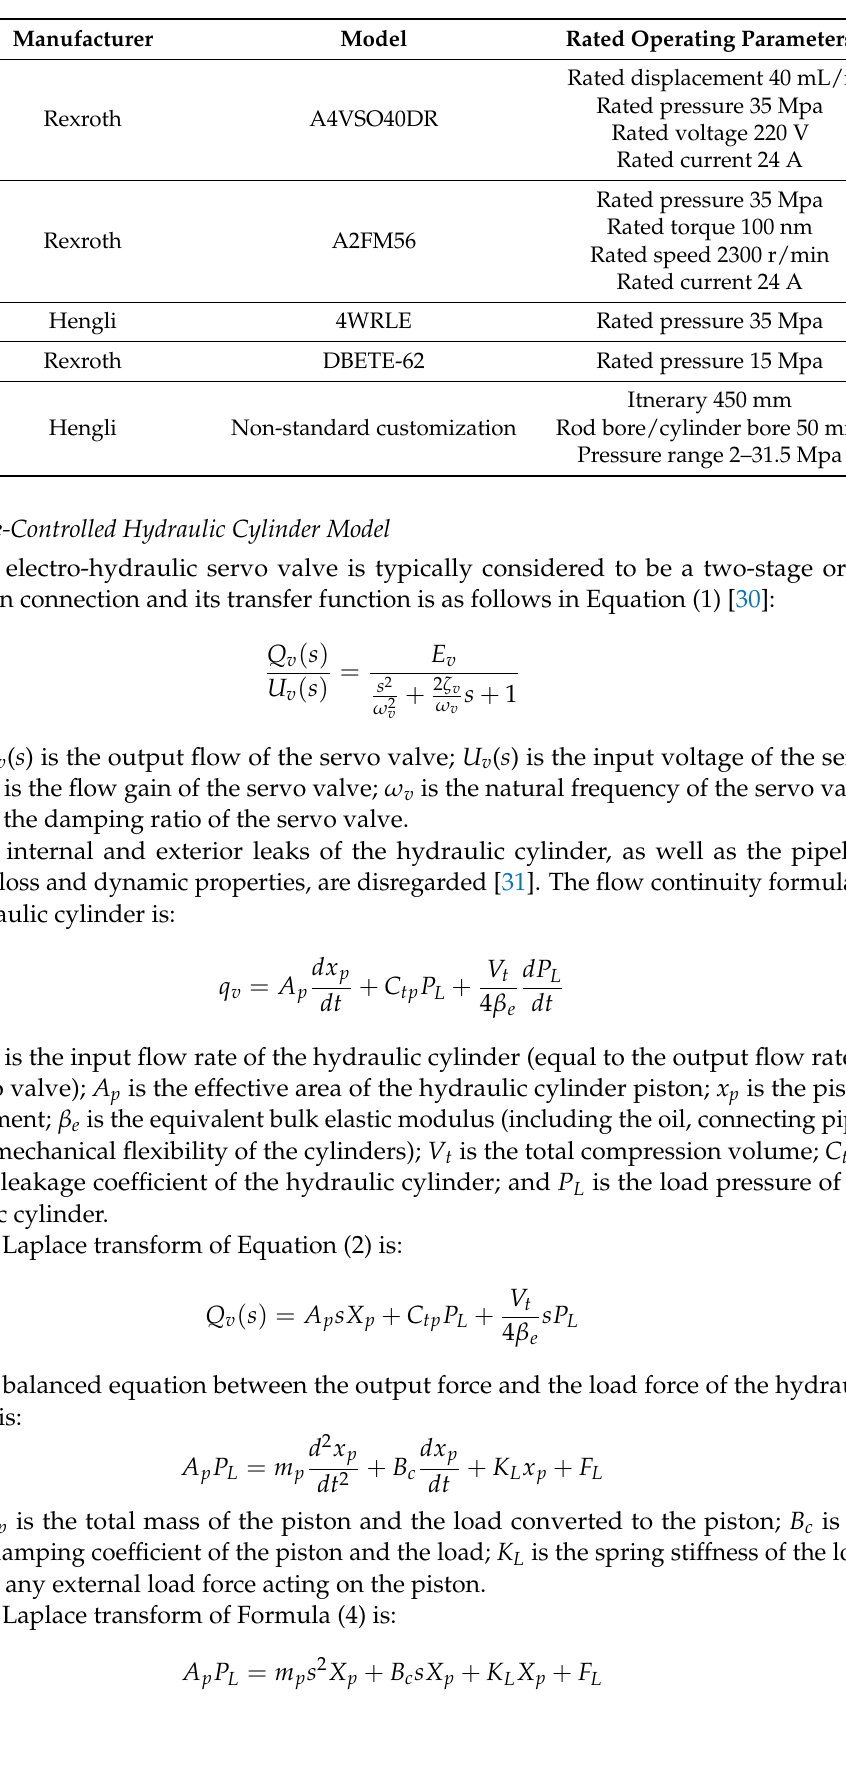
Table 2. Key components of PMSS operating